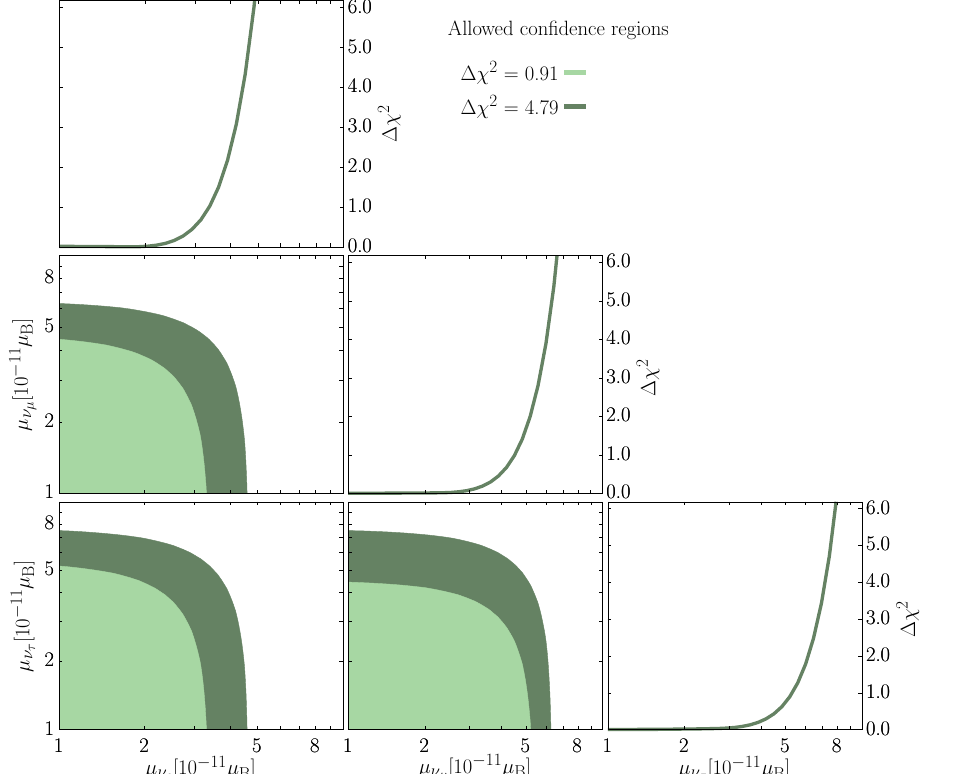
Figure 2 . Results for the magnetic moment scenario, assuming three independent parameters (one for each of the SM neutrino flavours). Since the neutrino magnetic moment is positive definite, the cuts have been taken according to a one-sided χ 2 distribution. In the central panels, we show the allowed confidence regions (at 1 σ and 2 σ , for 2 d.o.f. using one-sided intervals) while in the right-most panels we show the profile of the ∆ χ 2 for each of the parameters individually. In each panel, the results are obtained after minimization over the undisplayed